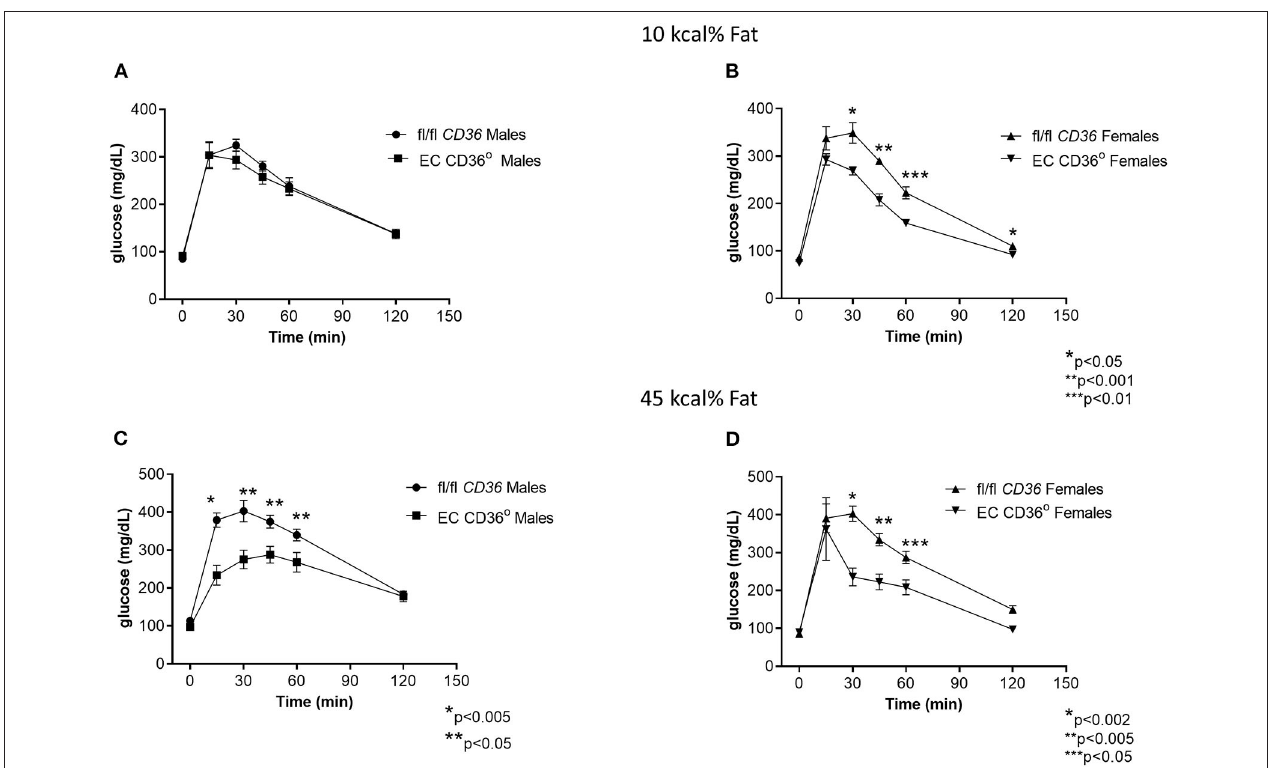
FIGURE 5 | Glucose tolerance testing of EC CD36 ◦ and fl/fl CD36 mice after 8 weeks feeding ingredient matched diets. (A) Male mice fed with the 10 kcal% fat diet showed no significant differences (fl/fl CD36 , n = 5; EC CD36 ◦ , n = 6). (B) Female mice fed with the 10 kcal% fat diet showed significant differences at 30, 45, 60, and 120min. AUC was significantly different (fl/fl CD36 : 26,939 ± 688; EC CD36 ◦ : 20,815 ± 625, p = 0.001) (fl/fl CD36 , n = 5; EC CD36 ◦ , n = 3). (C) Male mice fed with the 45 kcal% fat diet showed significant differences at 15, 30, 45, and 60min. AUC was significantly different (fl/fl CD36 : 36,455 ± 1,589; EC CD36 ◦ : 28,080 ±